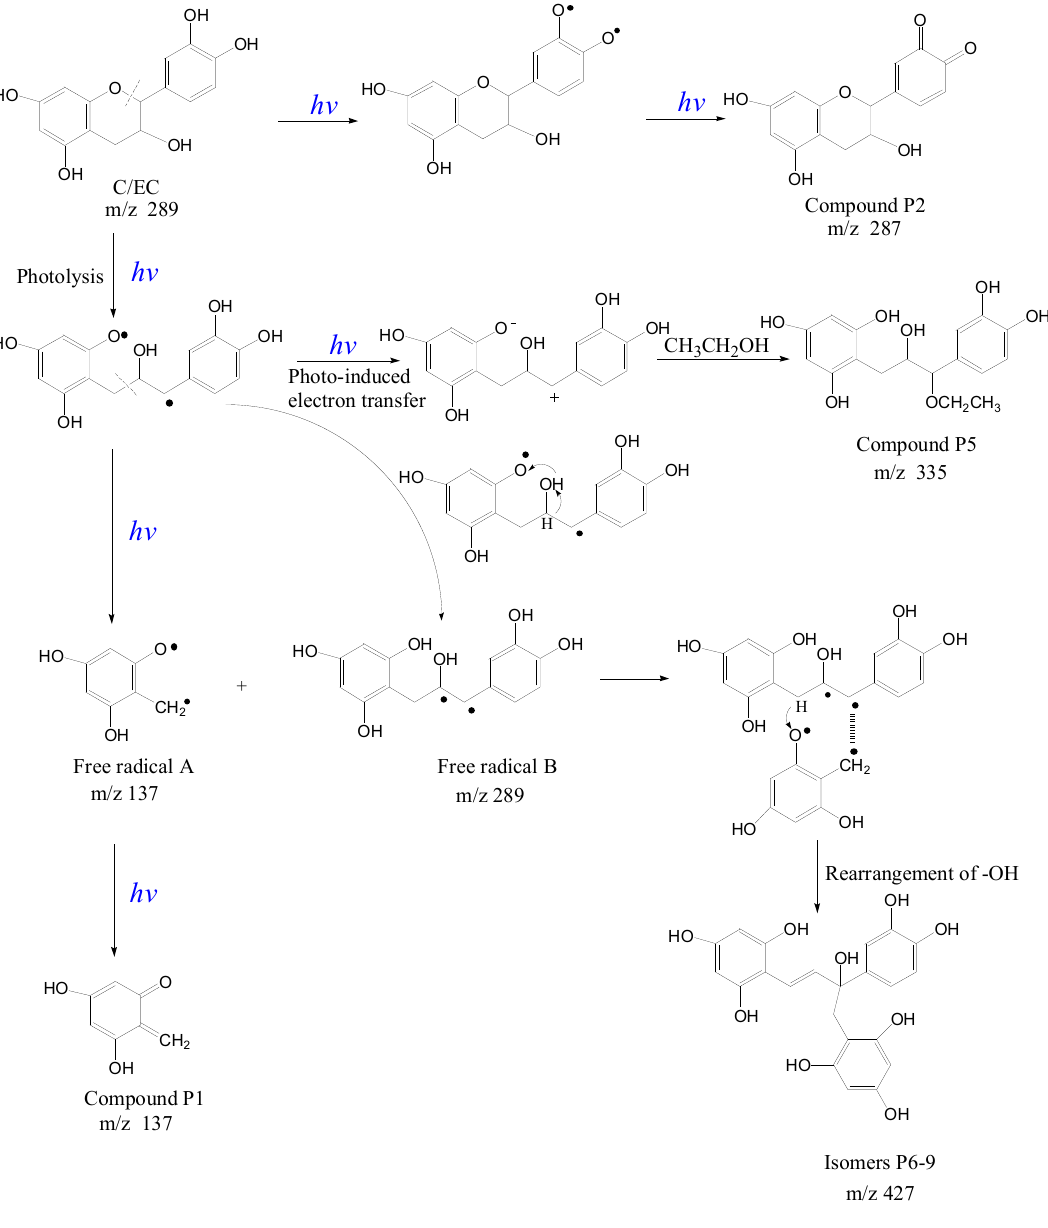
Figure 6. Proposed photolytic reaction mechanism of EC/C. Table 2. The 2,2-diphenylpicrylhydrazyl (DPPH) scavenging abilities of individual catechins before and after UVB radiation ( μ M trolox) 1 .